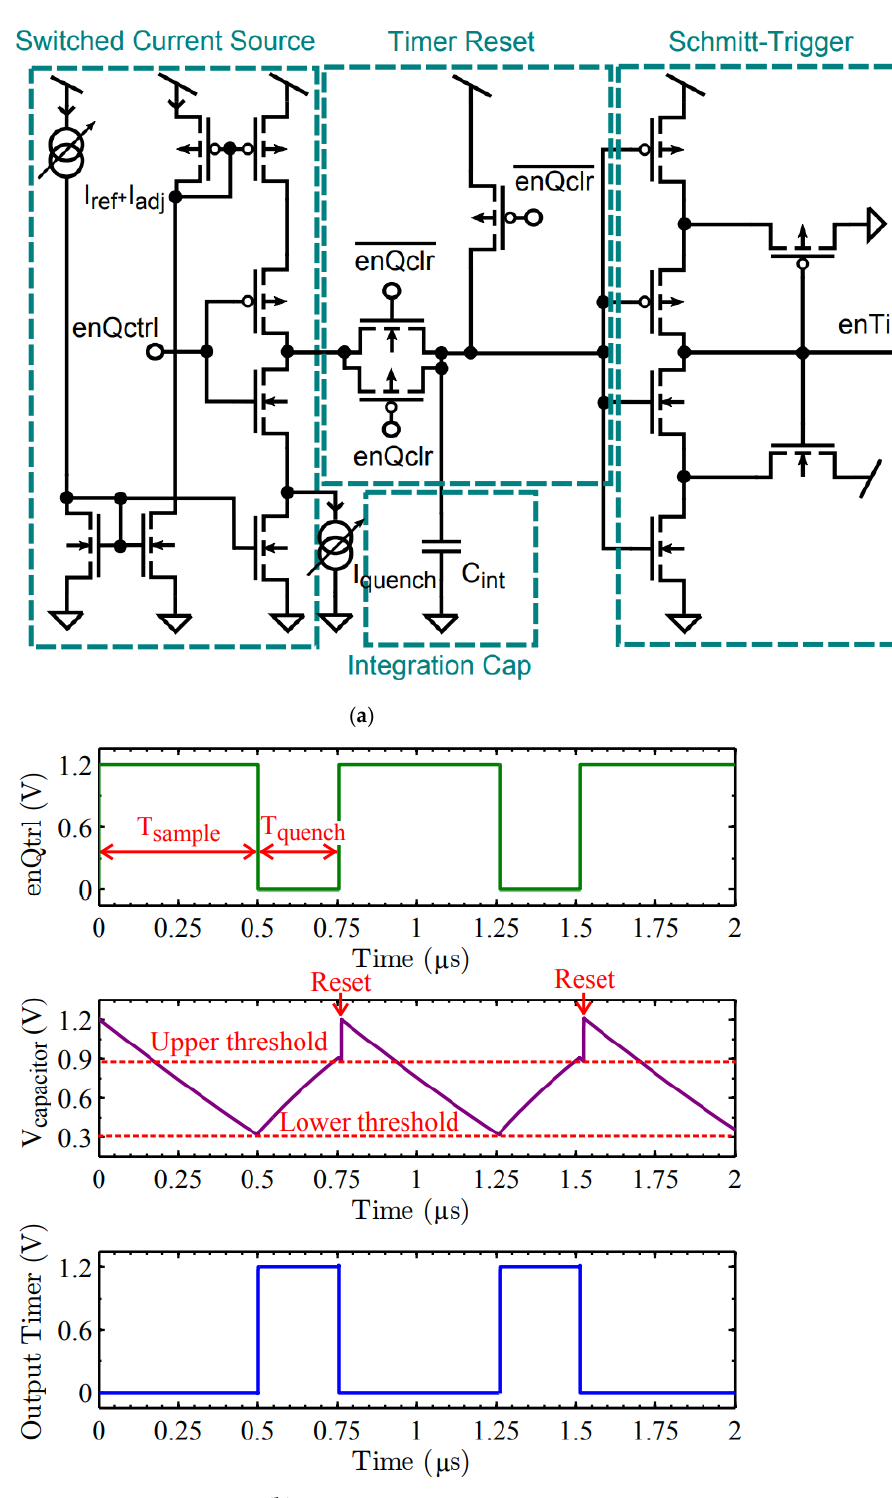
Figure 11. ( a ) Circuit implementation of the quench timer, ( b ) simulated output waveforms of the quench timer. The quench timer is free running by using an ideal delay element for feedback as a substitute for the state machine.